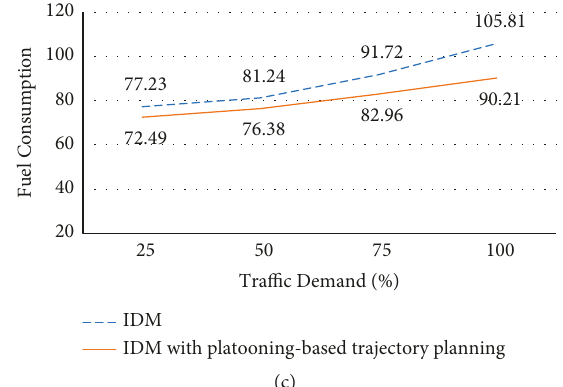
Figure 8: Average fuel consumption(ml) of CAVs in the equivalent conventional intersection. (a) Average fuel consumption for IDM and IDM with platooning. (b) Average fuel consumption for IDM and IDM with trajectory planning. (c) Average fuel consumption for IDM and IDM with platooning-based trajectory planning.